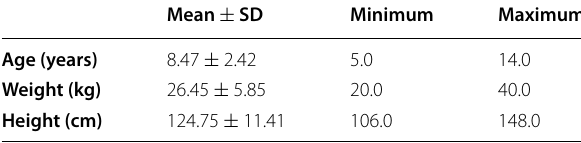
Table 1 General characteristics of the studied children ( n